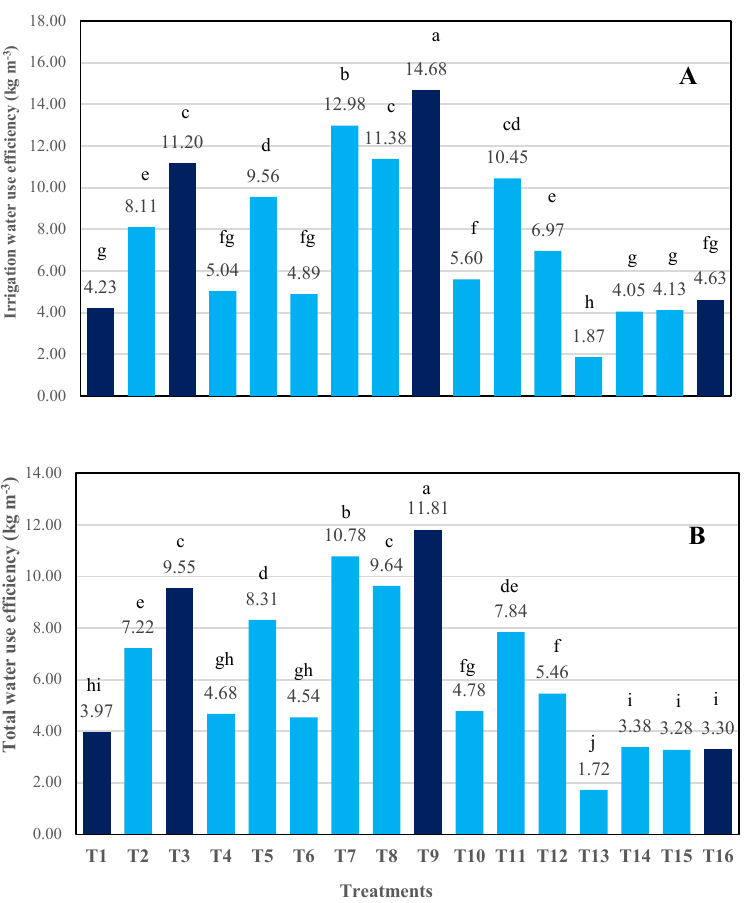
Figure 4. Irrigation water use efficiency ( A ) and total water use efficiency ( B ). Dark blue bars correspond to treatments with the same soil moisture tension during the two phenological stages. Different letters on the bars mean statistical differences ( p ≤ 0.05); n = 3. T1 to T16 are soil moisture tension treatments (kPa).